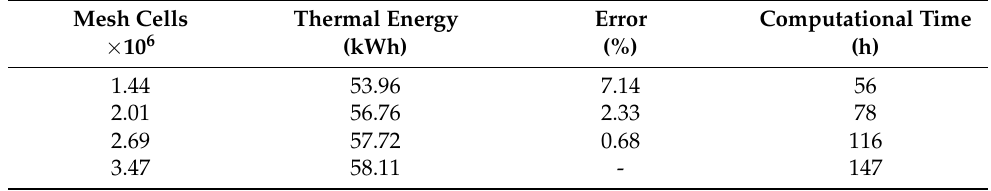
Table 2. Mesh sensitivity